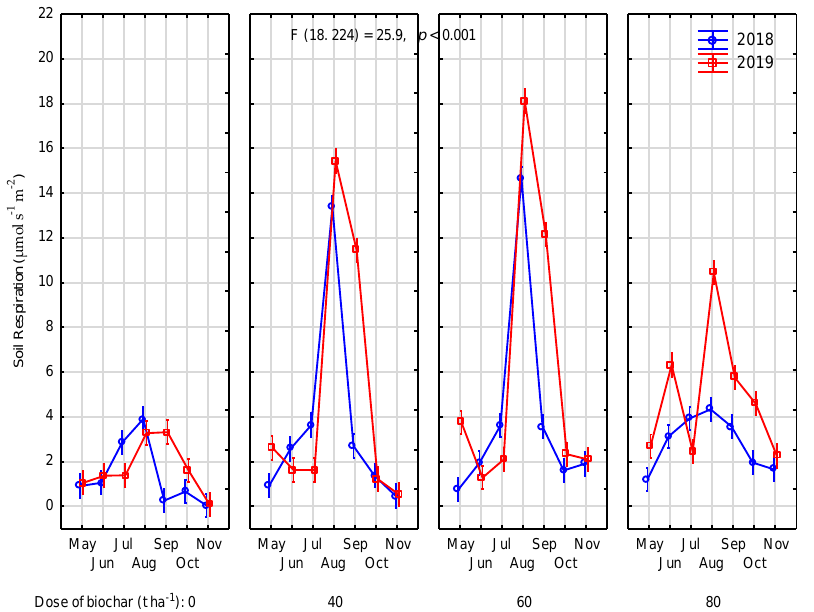
Figure 3. Distribution of soil respiration throughout the growing seasons in objects fertilized with biocarbon, without a protective plant (bare soil).